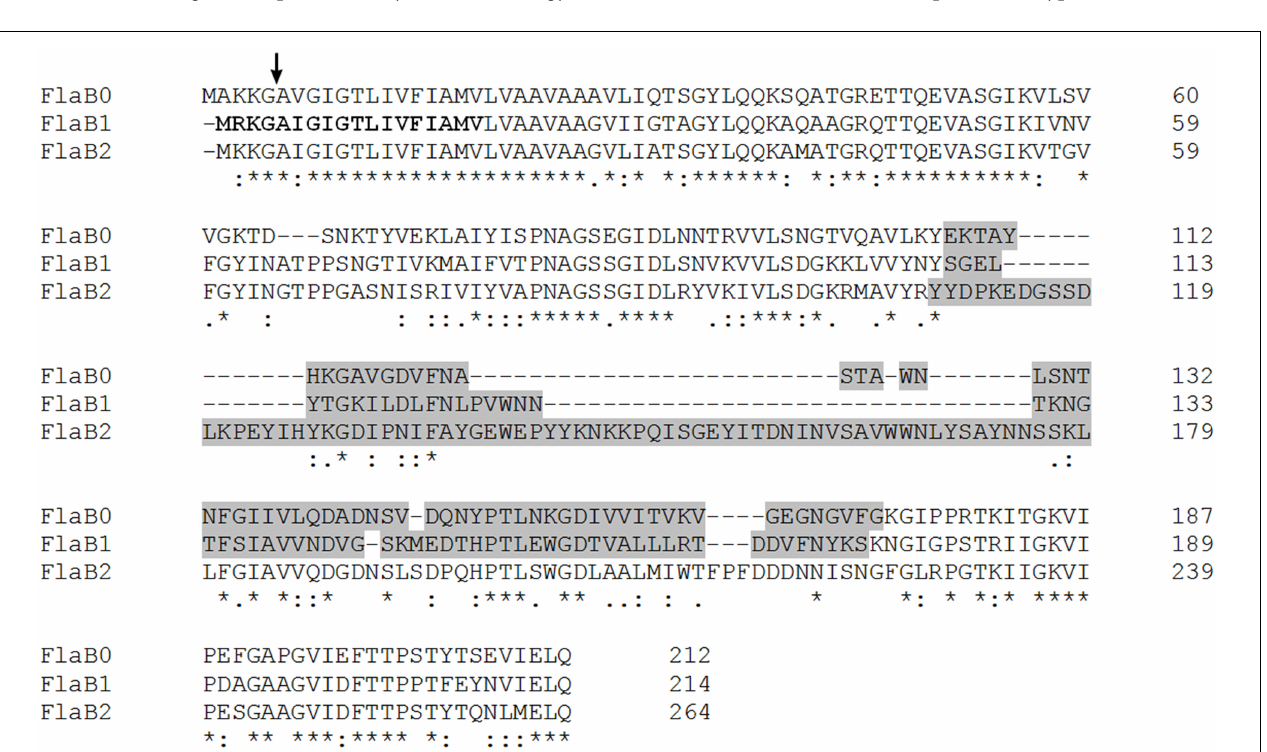
FIGURE 2 | Sequence alignment of the three P. furiosus flagellins. Amino acid identities for the three proteins are indicated by asterisks ( ∗ ); conservative amino acid exchanges are indicated by colons (:), and semi-conservative amino acid exchanges are indicated by dots (.). The arrow shows the signal peptidase processing site. Bold ladders